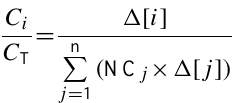
Figure 3. The instrumental set-up for open-path FTIR measure- ments of smoke at the different burns is shown: (a) Max Allen Drive; (b) Gibberagong; (c) Abaroo Creek (Day 1); (d) Abaroo Creek (Day 2); (e) Gulguer Nature Reserve and (f) Alfords